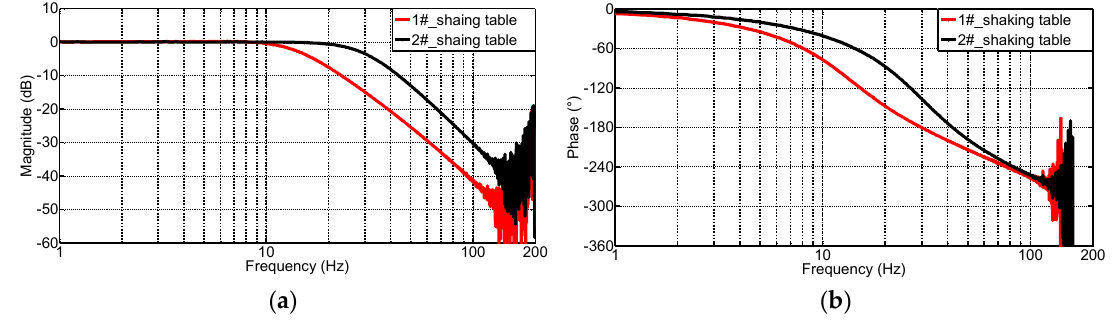
Figure 17. Frequency characteristics without synchronization control. ( a ) Magnitude frequency characteristics; ( b ) Phase frequency characteristics.